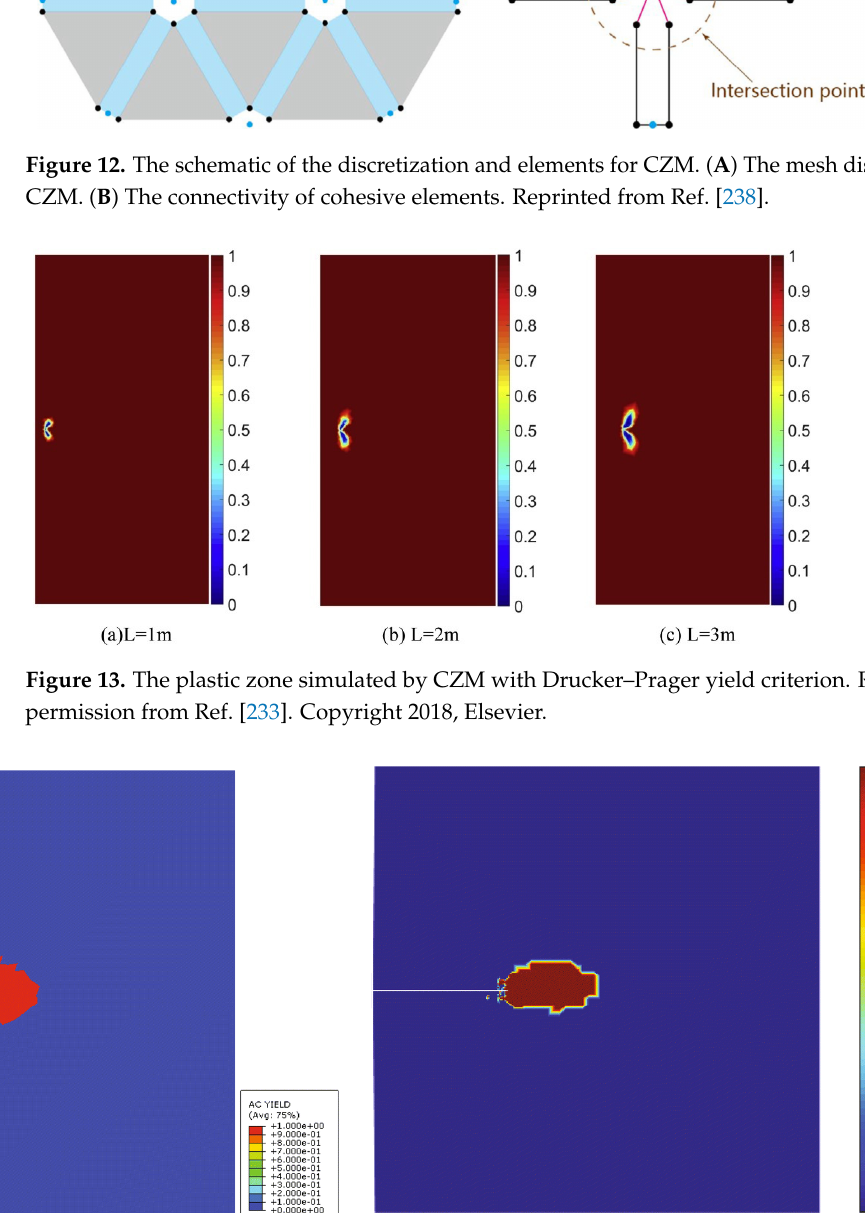
Figure 14. The comparison of plastic zone simulated using two methods. ( a ) Abaqus result. ( b ) XFEM result. Reprinted with permission from Ref. [223]. Copyright 2019, Springer Nature.